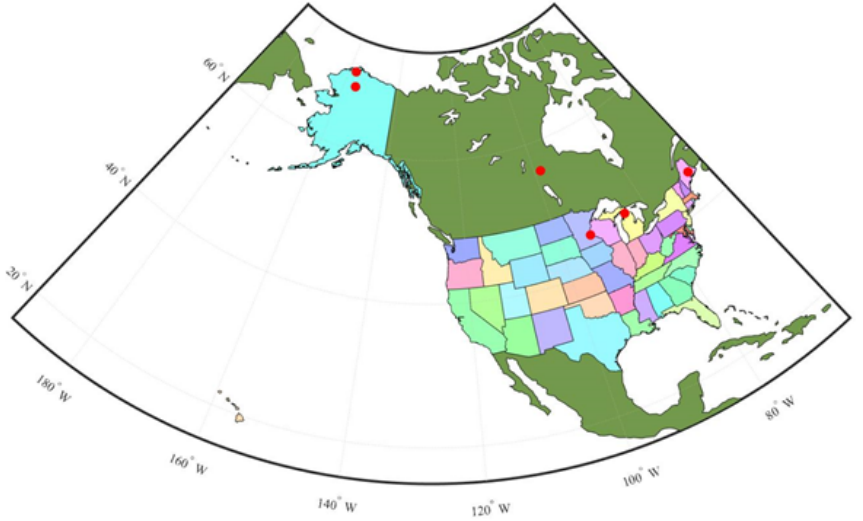
Figure 4. Map showing six sites used for TEM_Moss calibration. The red points represent the six sites: five are in the US and one is in Canada. US-Ivo: Ivotuk (alpine tundra); CA-NS3: UCI-1964 burn site (boreal forest); US-Ho1: Howland Forest (temperate coniferous forest); US-UMB: Univ. of Mich. Biological Station (temperate deciduous forest); US-KUT: KUOM Turfgrass Field (grassland); US-Atq: Atqasuk (wet tundra).